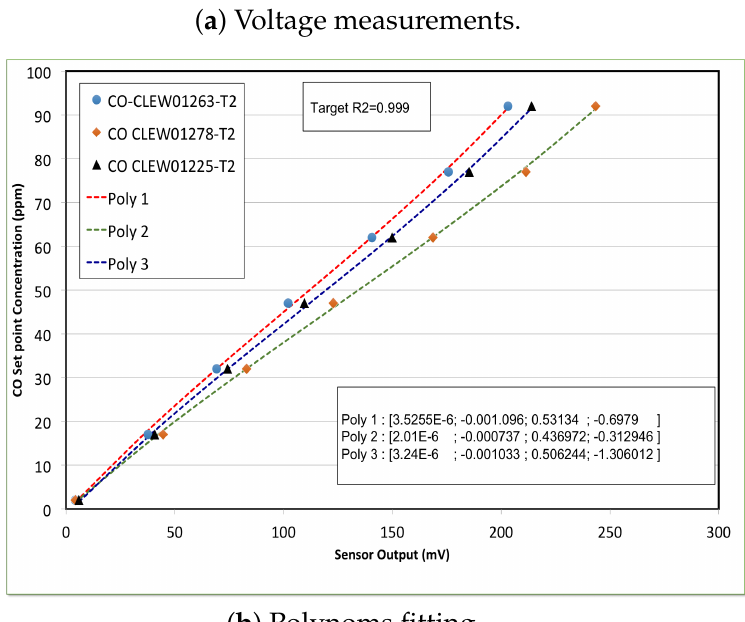
( b ) Polynoms fitting. Figure 13. CO sensor response to stepping of CO concentration before calibration, ( CO-CLEW01263-T2 , R 2 = 0.997333) ( CO-CLEW01278-T2 , R 2 = 0.997552) ( CO-CLEW01225-T2 , R 2 = 0.997573).